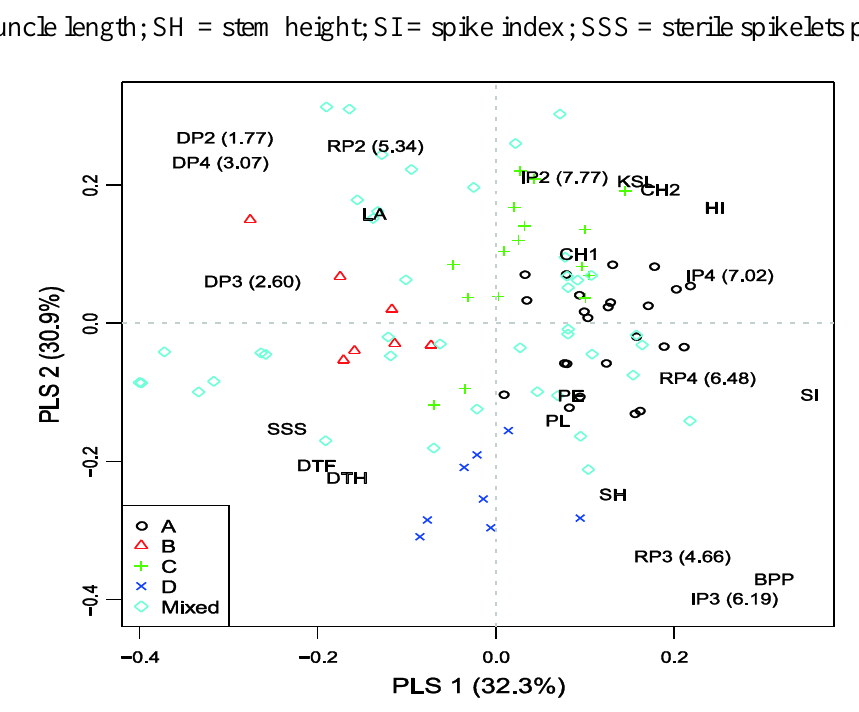
Figure 1. Triplot of the first and second partial least squares (PLS) components for agronomic traits for 96 wheat accessions tested across 9 environments. Environment codes are: IP, irrigated plot; RP, rainfed plot; DP, drought plot, 2, 2002 year, 3, 2003 year; 4, 2004 year. Number in parentheses ( x ) represent average yield across all accessions. Accessions are denoted according to subpopulations assignments and indicated by different symbols on the figure. Trait codes: BPP = above-ground biomass per plant; CH1 = flag leaf chlorophyll content at flowering date; CH2 = flag leaf chlorophyll content three weeks after flowering date; DTF = days to flowering; DTH = days to heading; HI = harvest index; KSL = number of kernels per spikelet; LA = flag leaf area; PE = peduncle extrusion; PL = peduncle length; SH = stem height; SI = spike index; SSS = sterile spikelets per